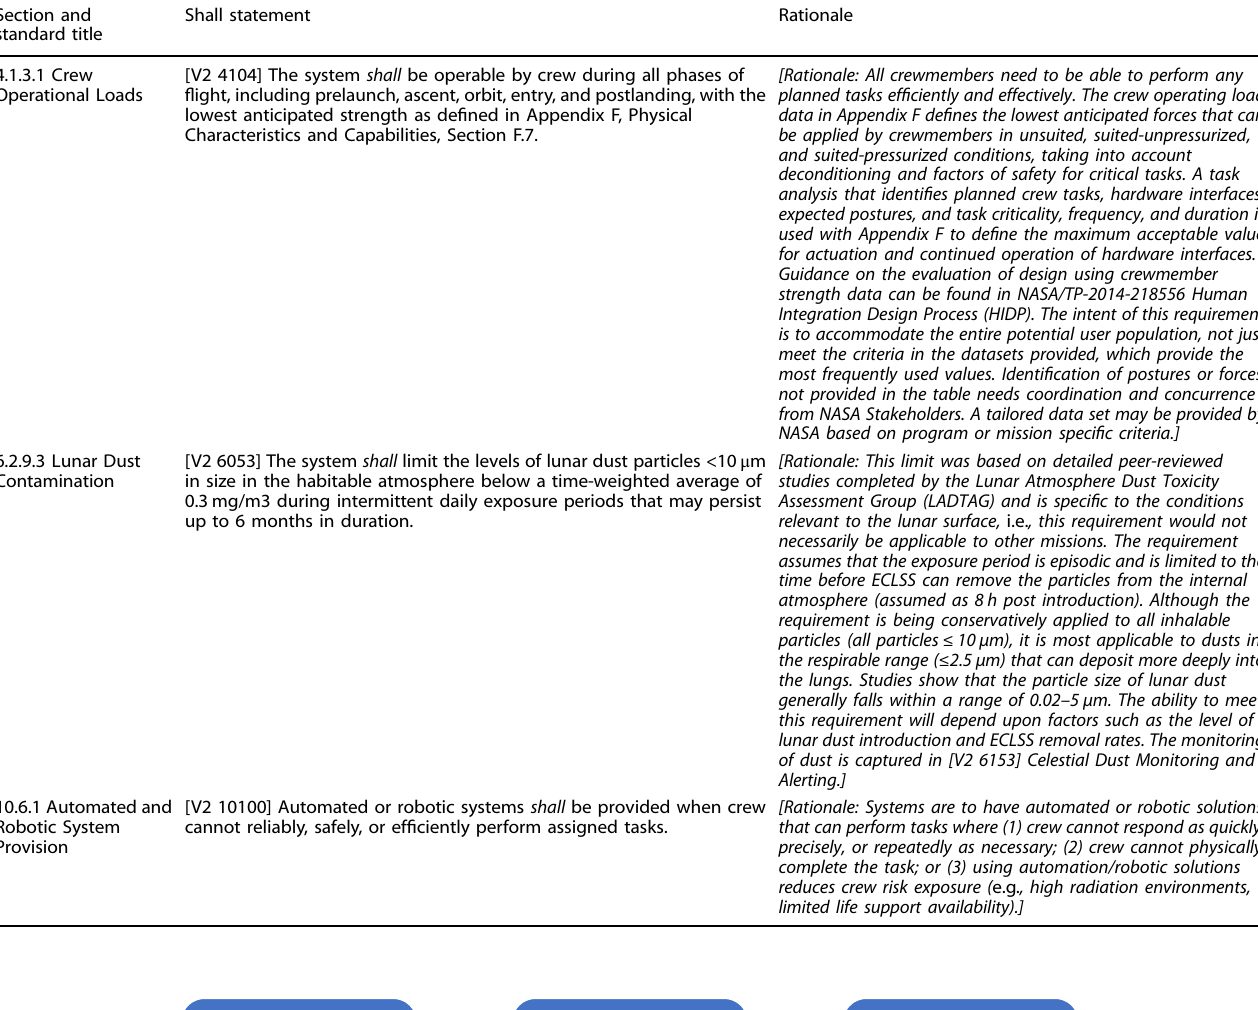
Table 2. Selected Examples of Technical Requirements from NASA-STD-3001 Volume 2.